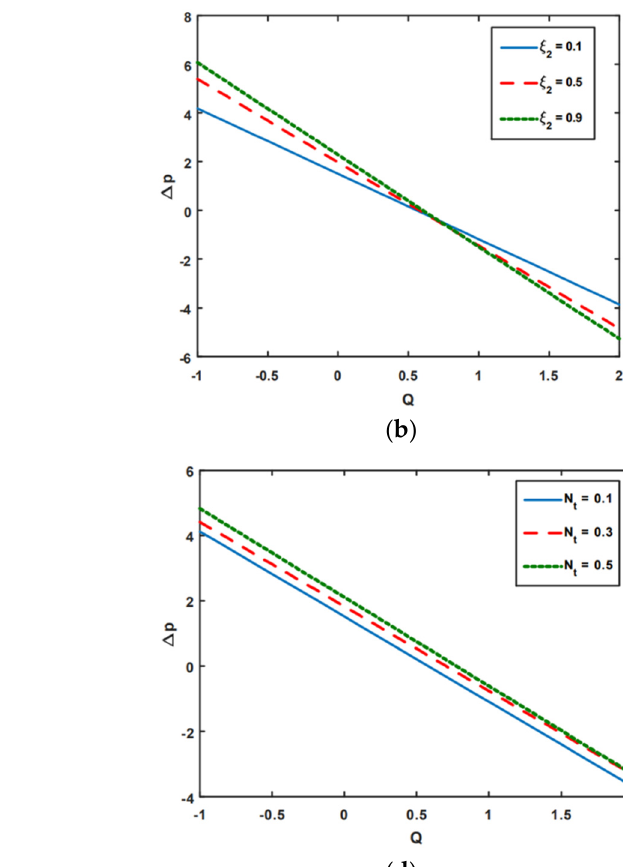
Figure 1. (a–d) Velocity impact on 𝜉 (cid:2869) , 𝐺 (cid:3045)(cid:3047) , 𝐺 (cid:3045)(cid:3030) , and 𝐺 (cid:3045)(cid:3007) .